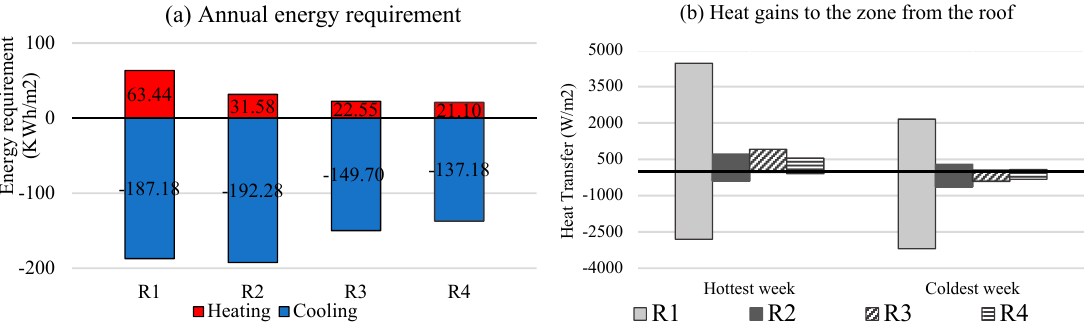
Figure 5. Comfort rates according to the fixed range (a) and the EN15251 for Category II (b) for different roof configurations.